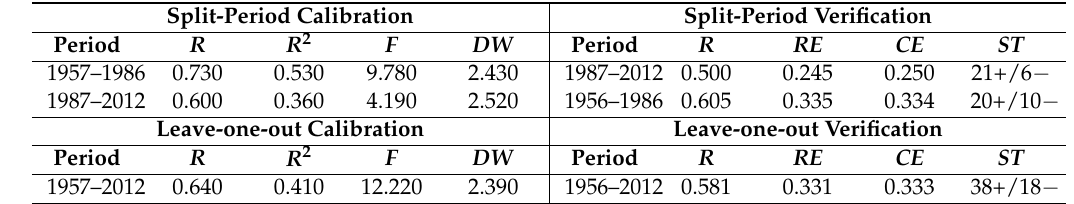
Table 3. Split-period and leave-one-out calibration and verification for the regression model.